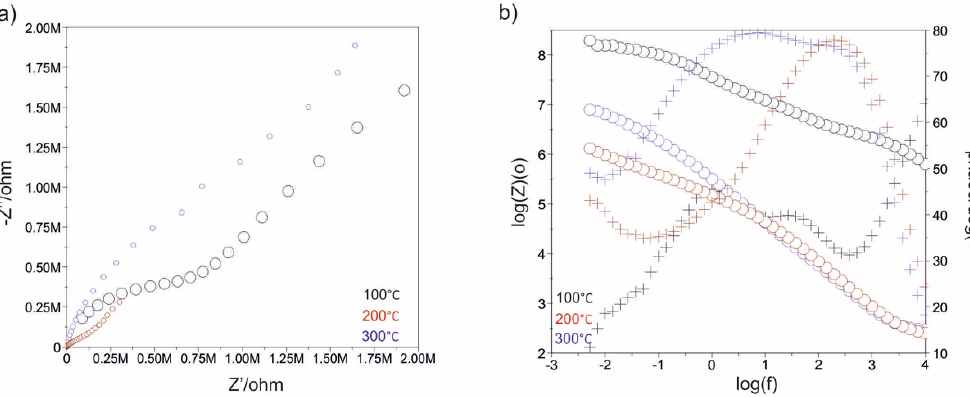
Figure 8. Impedance spectra determined for the ALD process in 500 cycles for the sandblasted samples: ( a ) Nyquist diagram, ( b ) Bode diagram.